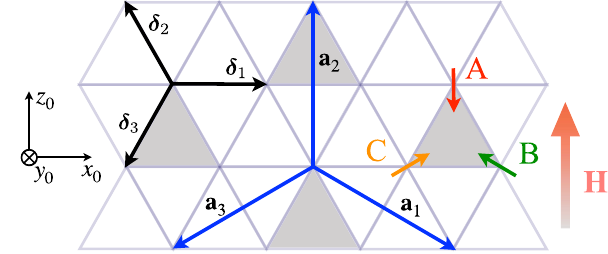
FIG. 3. Triangular lattice, its elementary translation vectors δ α , the primitive unit cell for the three-sublattice spin structures (shaded) with its basis vectors a α , and an example of such a structure with f A ; B ; C g sublattices. The laboratory reference frame f x 0 ; y 0 ; z 0 g and the field direction are indicated.